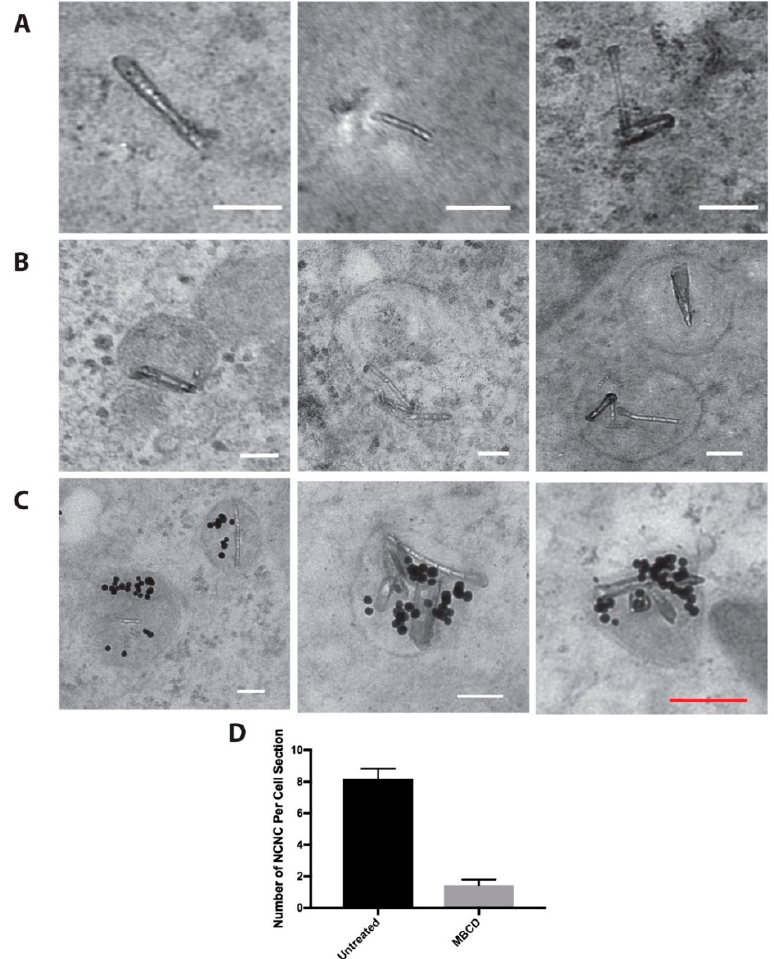
Figure 5. TEM images of NCNCs in cells. ( A ) Examples of NCNCs residing in the cytoplasm of HeLa Cells. Cells were treated with 5 µ g / mL NCNCs for 6 h. ( B ) Examples of NCNCs residing in vesicles within HeLa Cells. Cells were treated with 5 µ g / mL NCNCs for 6 h. ( C ) Examples of colloidal gold and NCNCs residing in the same vesicle. HeLa cells were treated with 5 µ g / mL NCNCs and 5 nM 20 nm colloidal gold for 6 h. ( D ) HeLa cells were treated with 5 µ g / mL NCNCs in the absence (untreated) or presence of endocytosis inhibitor M β CD for 6 h. NCNCs encountered per cell section was counted for each treatment, n = 2 separate experiments. t -test p -value = 0.0058. White scale bar indicates 100 nm, red scale bar indicates 200 nm.